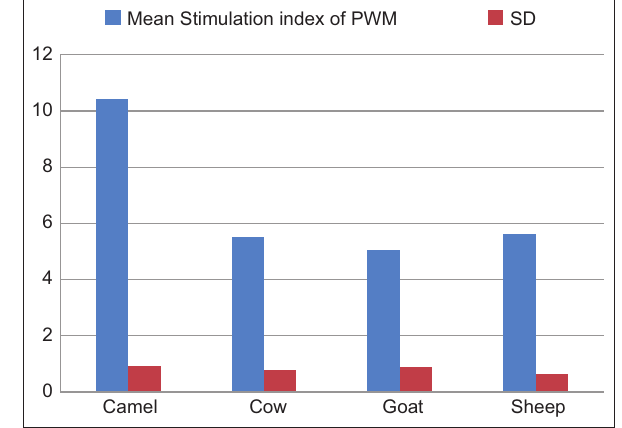
Figure-4: Comparison of stimulation indices of peripheral blood mononuclear leukocytes from camels, goats, sheep, and cows with concanavalin